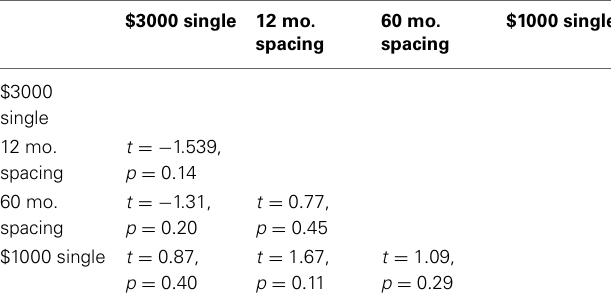
Table 4 | Pairwise comparisons between the best-fitting discount parameters for the Parallel model in each